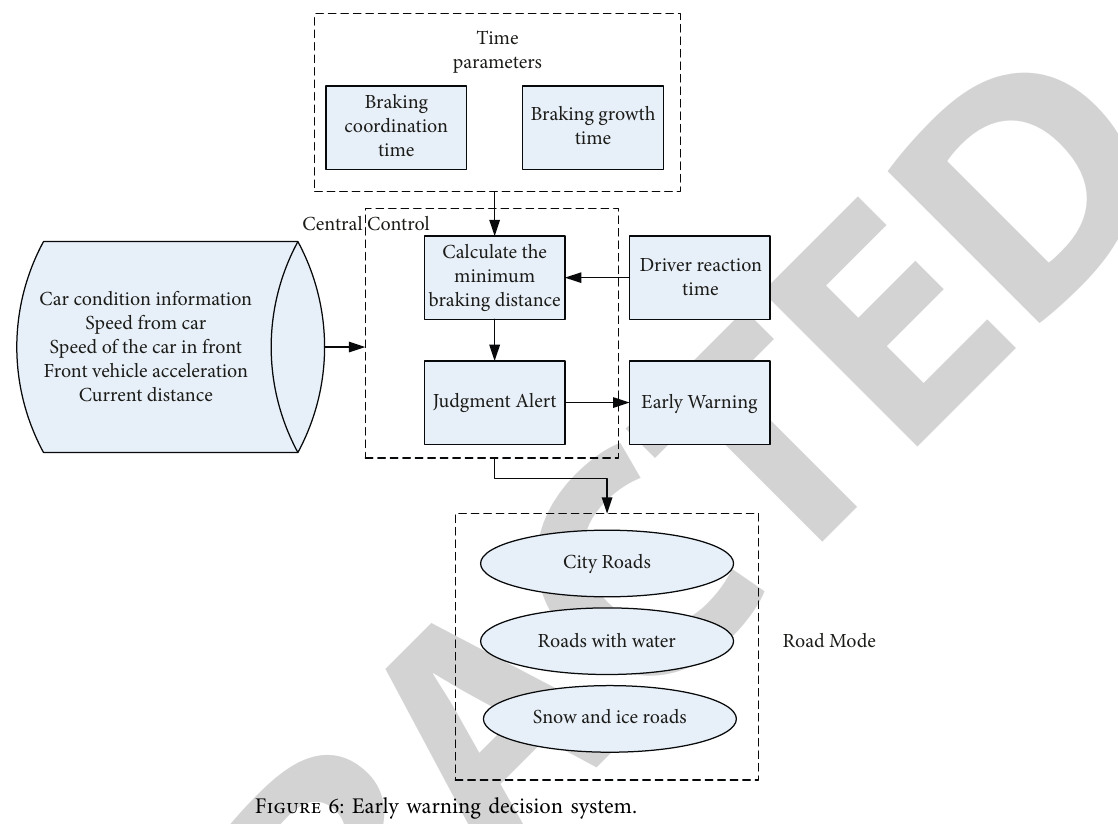
Figure 6: Early warning decision